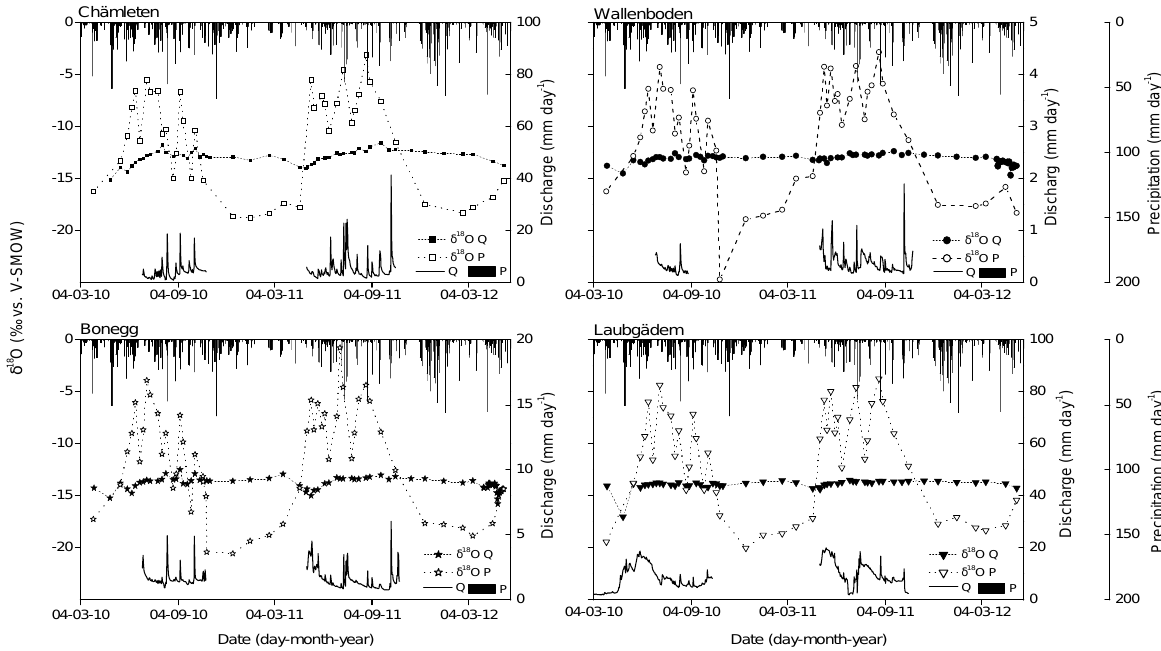
Fig. 4. Stable isotopes ( δ 18 O of H 2 O) of precipitation ( P , open symbols) and stream water ( Q , filled symbols) in the four micro catchments, discharge data (bottom of each plot; note the different scales), and precipitation data from the MeteoSwiss station Andermatt at the top of each plot (MeteoSwiss, 2012; scale on the rightmost side applies to all four plots).